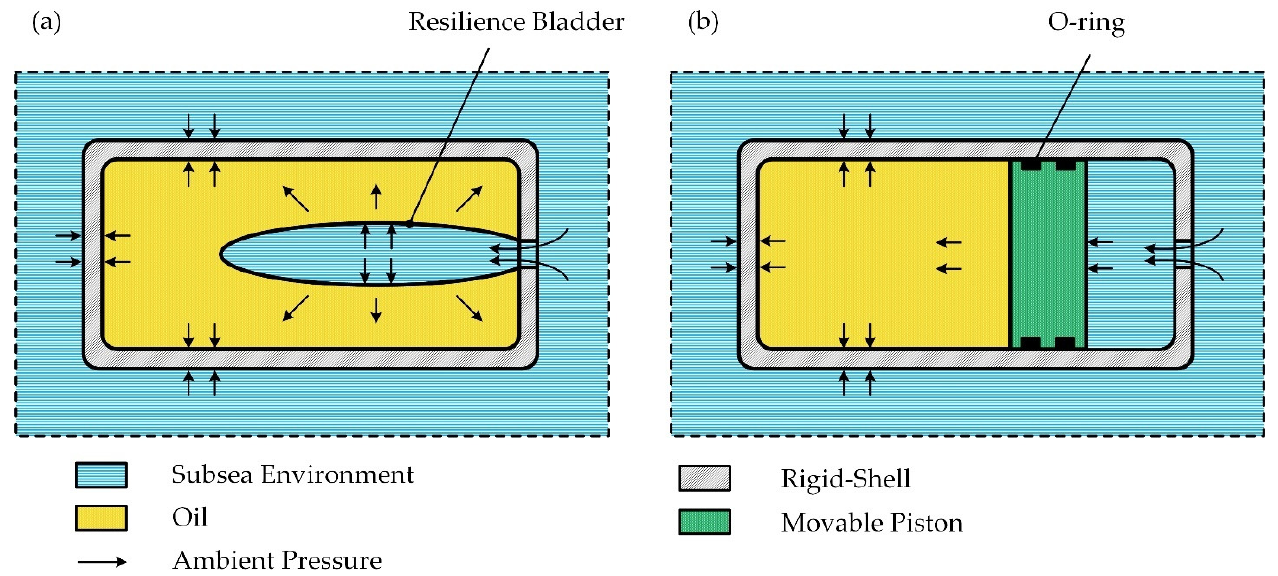
Figure 12. Schematic illustration of mechanism of pressure-balanced units: ( a ) resilience-bladder type, and ( b ) movable- piston type.